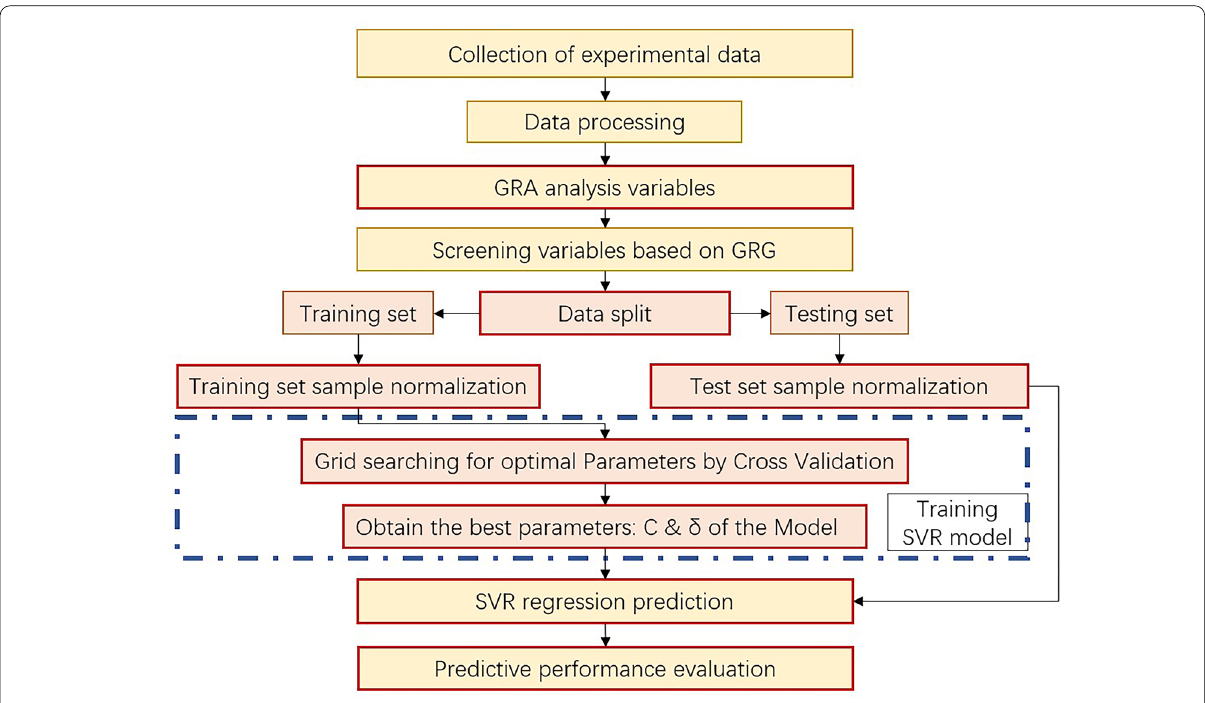
Fig. 4 Flow chart of the GRA–SVR regression prediction model